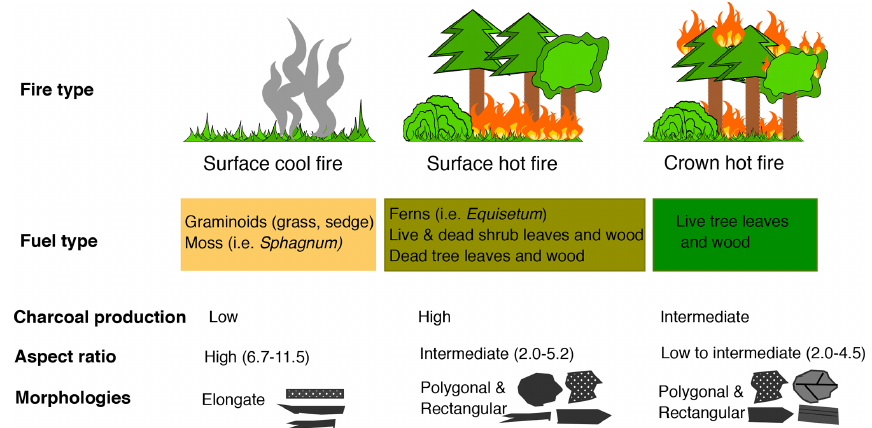
Figure 4. Schematic representation of fire types, and the potential link with fuel types burnt and predominant charcoal morphometrics (aspect ratio) and morphologies as well as charcoal